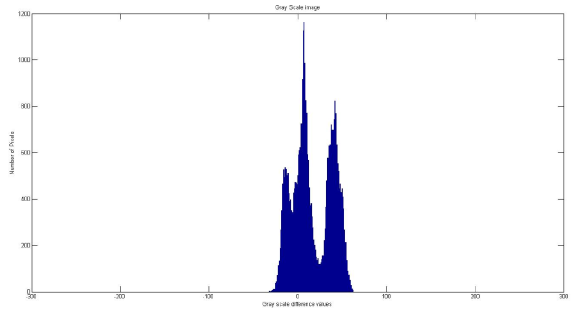
Figure 13. Histogram of images difference of test 3